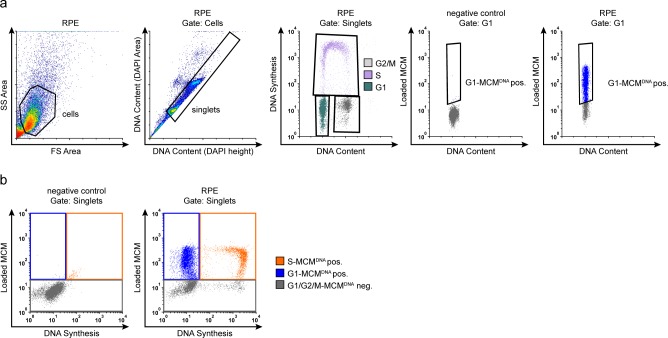
Flow cytometry gating.(a) Example flow cytometry gating with chromatin extracted ARPE-19 (RPE) cells from Figure 1d, measuring loaded MCM (anti-MCM2), DNA Synthesis (EdU incorporation) and DNA content (DAPI). Gating to discriminate cells from debris was on FS-area vs SS-area, singlets (individual cells) from clumps of cells/doublets was on DAPI height vs DAPI area, cell cycle phases were determined on DAPI vs EdU Non-specific background staining by the secondary antibody was measured using a negative control sample stained without primary antibody, only secondary antibody. This background threshold gate was applied to experimental samples; G1-MCMDNA-positive cells were identified first by DNA content and EdU negative status (G1) and then by MCM2 signal. (b) Example flow cytometry color gating with chromatin extracted ARPE-19 cells from Figure 1d. Left: Negative control to define background staining with neither EdU detection nor MCM2 primary antibody. Cells were stained with DAPI, subjected to EdU detection chemistry, and stained with secondary antibody. Background thresholds were set using these controls and applied to experimental samples. Right: Experimental samples in main Figure 1d showing the gating to identify DNA synthesis (EdU), and loaded MCM (anti-MCM2). Gates define color schemes for color dot plots.